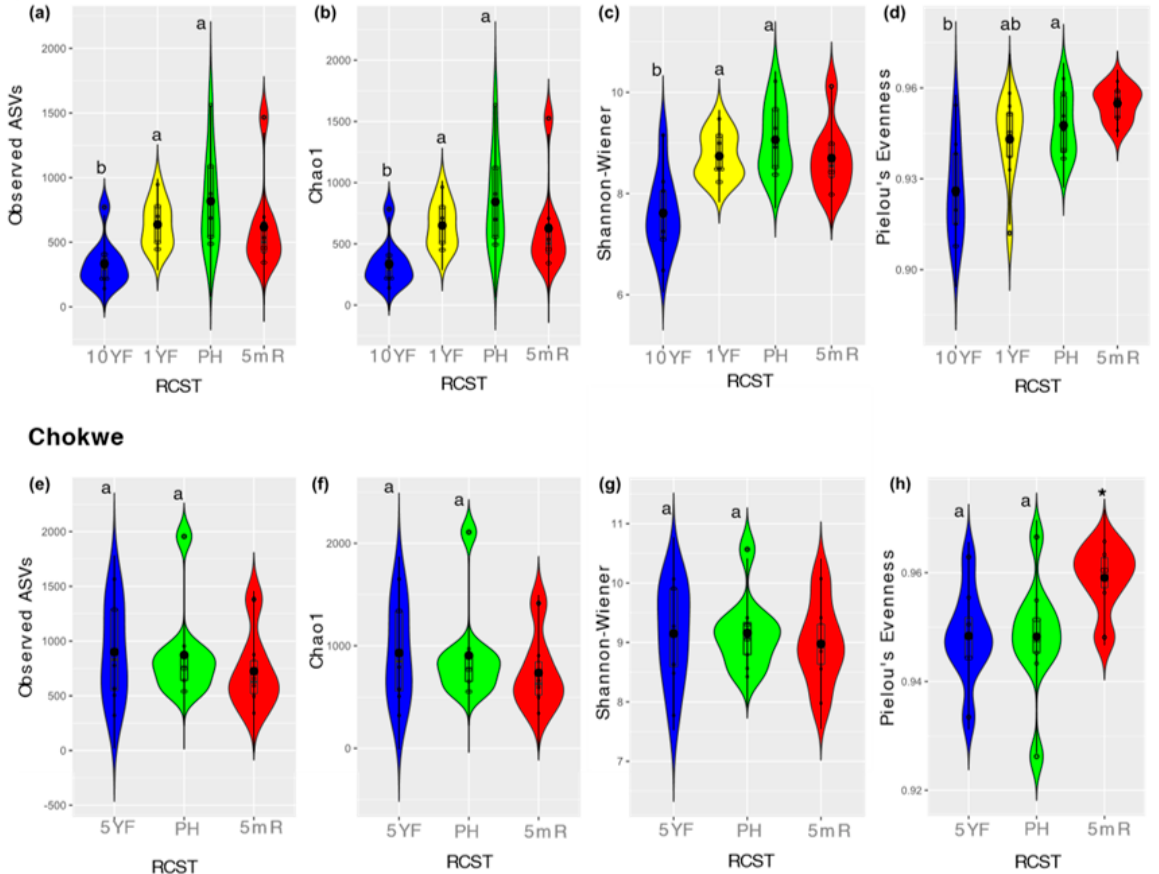
Figure 2. Observed ASVs, Chao1, Shannon–Wiener index of diversity and Pielou’s evenness in Umbeluzi ( a – d ) and Chokwe ( e – h ). Black-filled dots depict mean values on the boxplot. Plots for 10YF, 1YF or PH with different superscript letters for each location are significantly different (Bonferroni adjusted p < 0.05) based on Kruskal–Wallis or Mann–Whitney test. 5mR is only compared to PH. Plots for 5mR with asterisks (*) is significantly (Wilcoxon rank-sum test p < 0.05) different from PH.